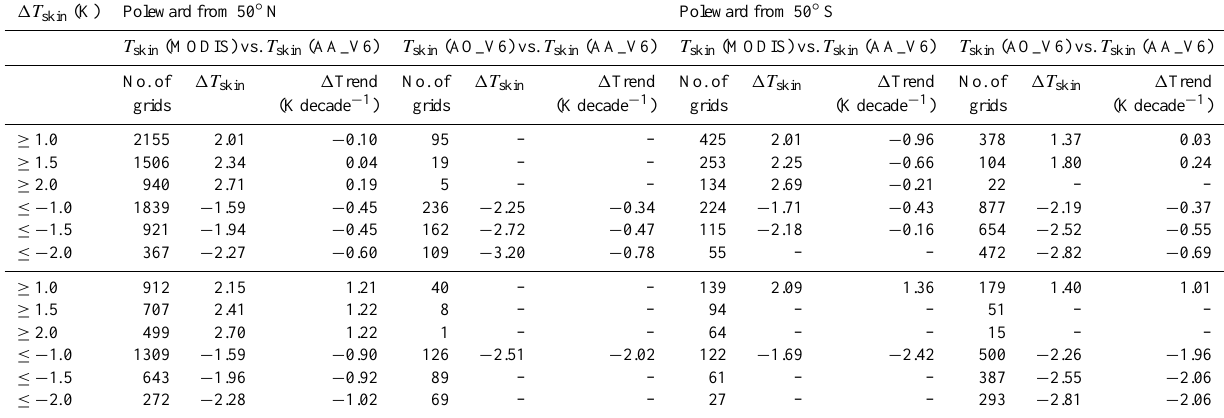
Table 4. Uncertainties of the satellite-derived surface skin temperature rate (or trend; (cid:49) Trend) due to the temperature difference ( (cid:49)T skin ) for the cases of T skin (MODIS) minus T skin (AA_V6) and T skin (AO_V6) minus T skin (AA_V6) in the upper portion of the table. Also, the values of uncertainties provided in the lower portion of the table indicate the cases of ± (cid:49) Trend with respect to ± (cid:49)T skin (double signs in the same order). The uncertainties are not shown when the number of the grid (1 ◦ × 1 ◦ ) points (i.e., No. of grids in the table) is less than 100. (cid:49)T skin (K) Poleward from 50 ◦ N Poleward from 50 ◦ S T skin (MODIS) vs. T skin (AA_V6) T skin (AO_V6) vs. T skin (AA_V6) T skin (MODIS) vs. T skin (AA_V6) T skin (AO_V6) vs. T skin